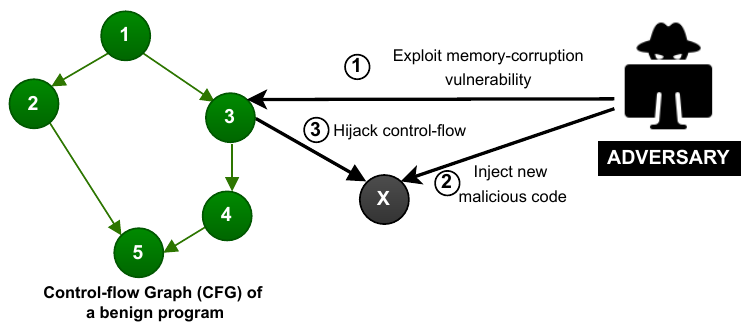
Figure 1. Code-injection attack. The Control Flow Graph (CFG) represents the legitimate execution flows of a benign software, where each graph node (Nodes 1–5) denotes a software instruction. A code-injection adversary performs the actions